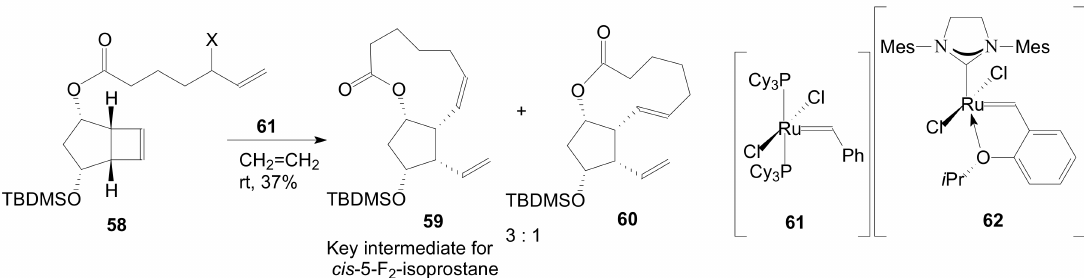
Scheme 11. A study for the synthesis of the key lactone intermediate 59 by RCM of cyclobutene intermediate 58 and ethylene with the Grubbs’ catalyst 61 . The Hoveyda-Grubbs’ catalyst 62 .